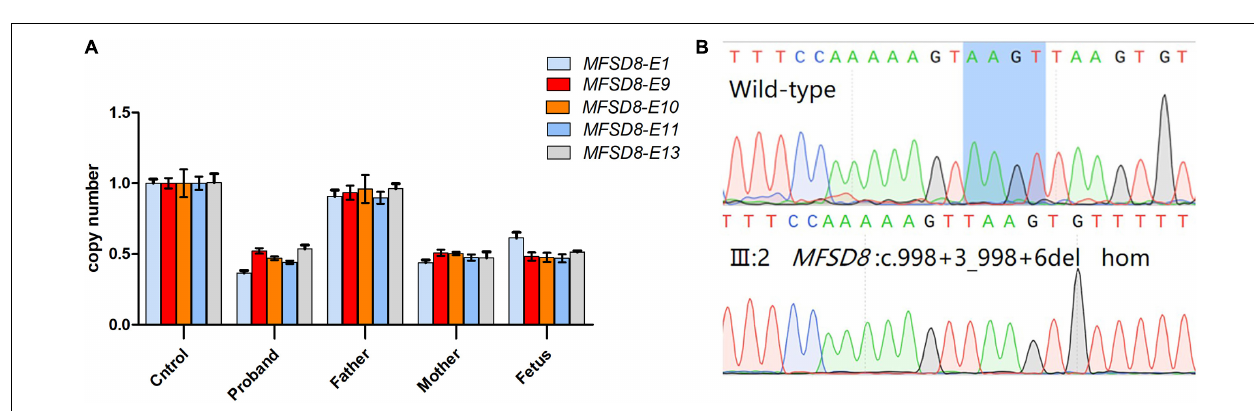
FIGURE 5 | Prenatal genetic analysis of the fetus. (A) Quantitative real time PCR analysis of MFSD8 exon 1, 13, 9–11 in the family. The control genome was normalized to one. Different colors show different exons: light blue for exon 1, red for exon 9, orange for exon 10, deep blue for exon 11, gray for exon 13. The X -axis shows different samples. (B) Sanger sequencing analysis of the fetus(III:2) showed intron variants in